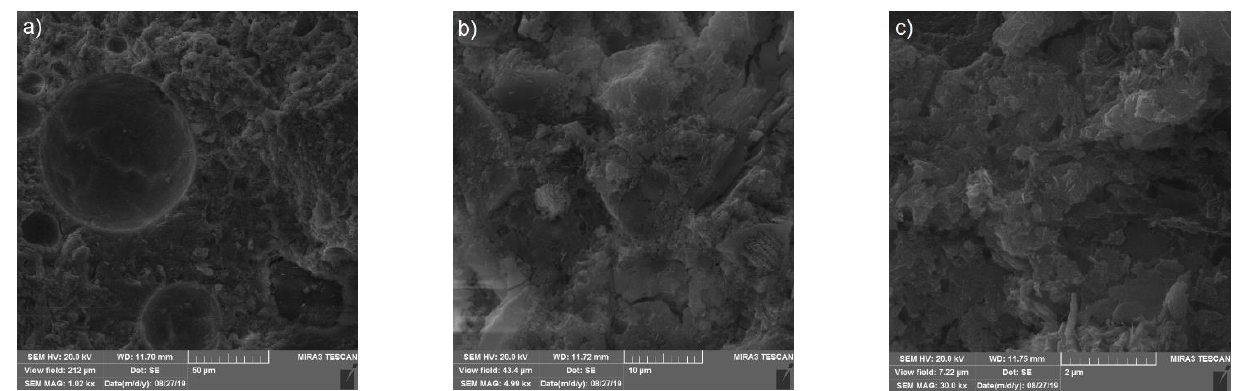
Figure 9. SEM micrographs of the hardened mortar sample P20-M taken with three different magnifications: ( a ) 1.02 k×; ( b ) 4.99 k× and ( c ) 30.0 k×.